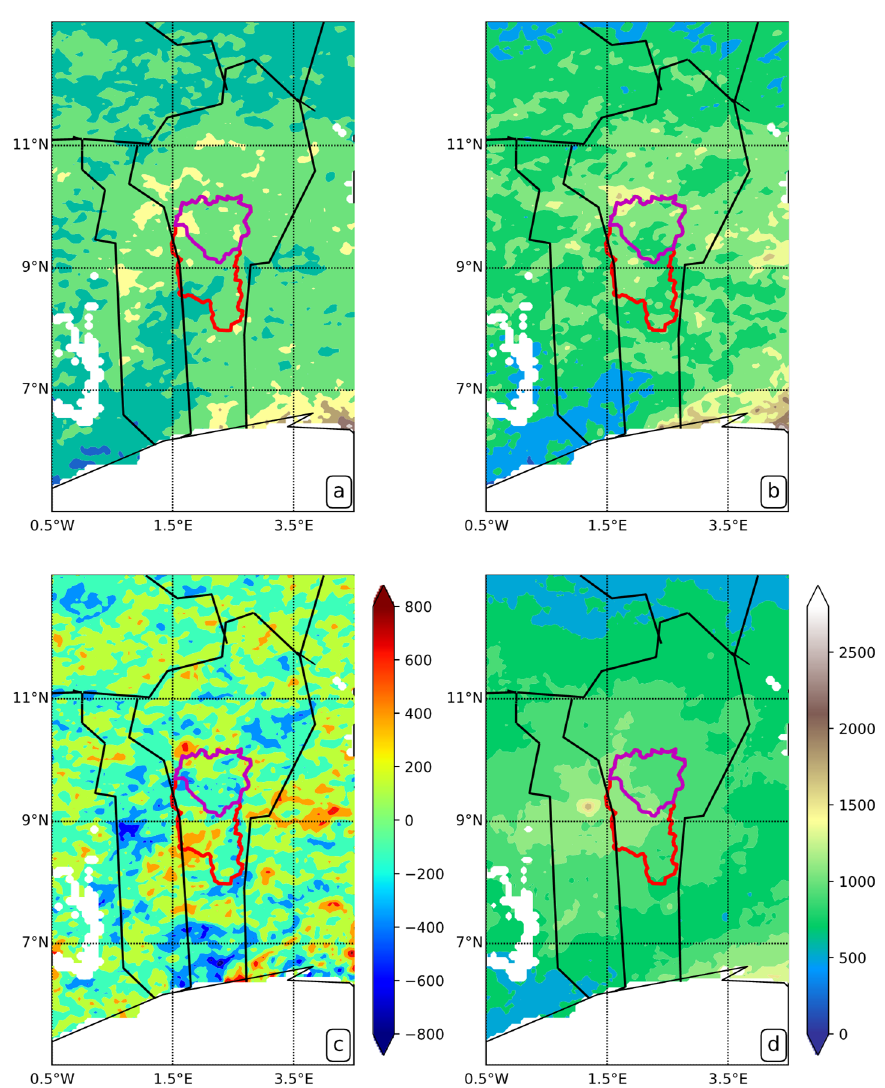
Figure 7. JJAS precipitations for the flooding year 2010 in the Savè catchment (red contour), and the Bétérou catchment (purple contour): ( a ) WRF-only simulations; ( b ) coupled WRF-Hydro (WRF-H) simulations; ( c ) difference between WRF-H and WRF (WRF-H minus WRF); and ( d ) CHIRPS precipitation. The color bar of Figure 5d is used as a common color bar for Figure 5a,b,d.